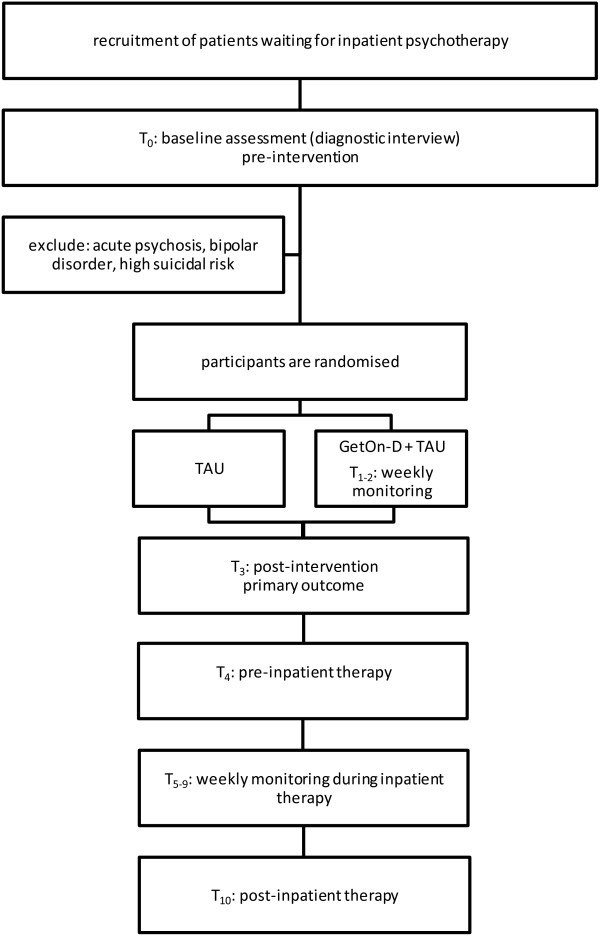
Study flow diagram.